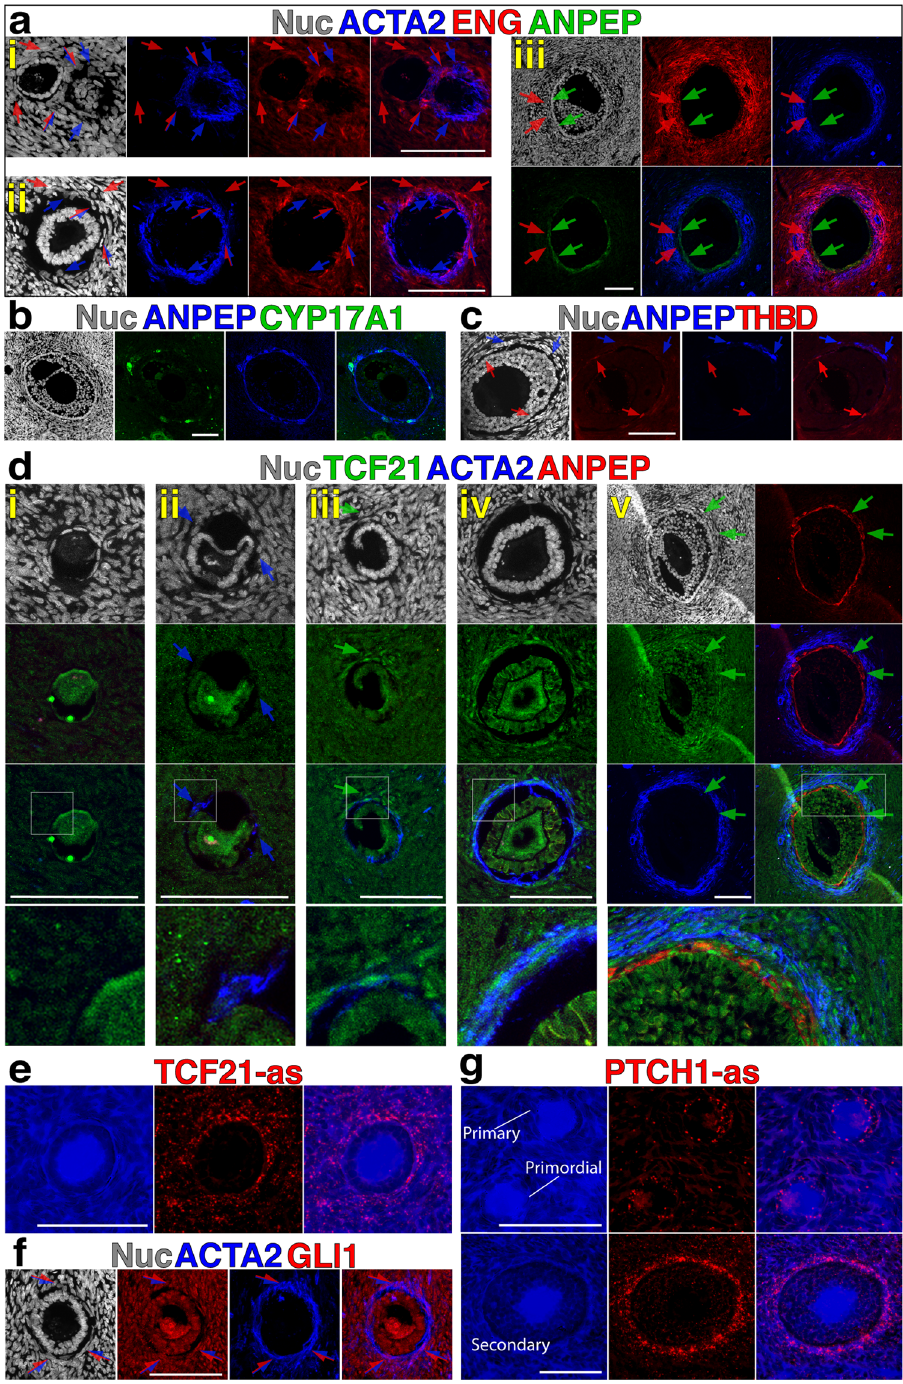
Fig. 3 Immunolabeling and RNA ISH reveals progressive emergence of theca lineage markers. a Immunostaining for ACTA2, ENG and ANPEP in primary (i), secondary (ii) and early antral (iii) follicles. Red, blue, and red/blue arrows point to cells that are positive for ENG, ACTA2 or both markers, respectively; in (iii) green arrows indicate ANPEP + cell layer, while red arrows indicate an ENG + area that is negative for both ANPEP and ACTA2. b – c Staining of early antral follicles for ANPEP and CYP17A1 ( b ), or ANPEP and THBD ( c ); red arrows indicate THBD + cells and blue arrows show ANPEP + cells. d Representative Immunolabeling for TCF21, ACTA2 and ANPEP in (i) primordial, (ii) transitioning primary, (iii) primary, (iv) secondary and (v) early antral follicles. Blue arrows indicate ACTA2 + cells and green arrows indicate TCF21 + cells; white boxes indicate areas magni fi ed in bottom panels. e RNA ISH labeling for TCF21 RNA in a primary follicle. f Staining for ACTA2 and GLI1 in a secondary follicle; representative cells expressing both markers are indicated with red and blue arrow. g RNAScope labeling for PTCH1 RNA in primary and secondary follicles. Blue channel shows transmitted light in ( e and g ). Scale bars – 100 μ m. a – e Nuclear counterstain (DAPI) is shown in white in ( a – d and f ). as = anti-sense RNA probe in ( e and g